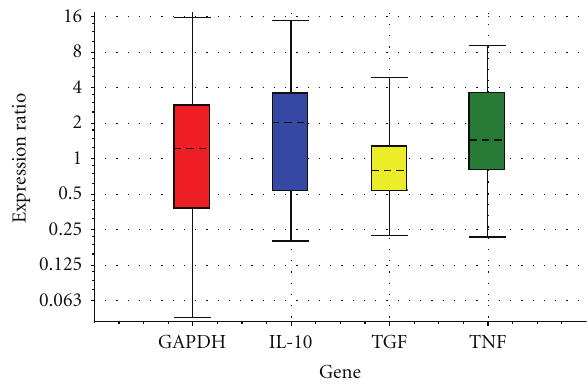
Figure 3: Relative expressions of IL-10, TGF- β 1, and TNF- α ob- tained from echinacea versus control after processing RT-PCR with REST in 40th day.